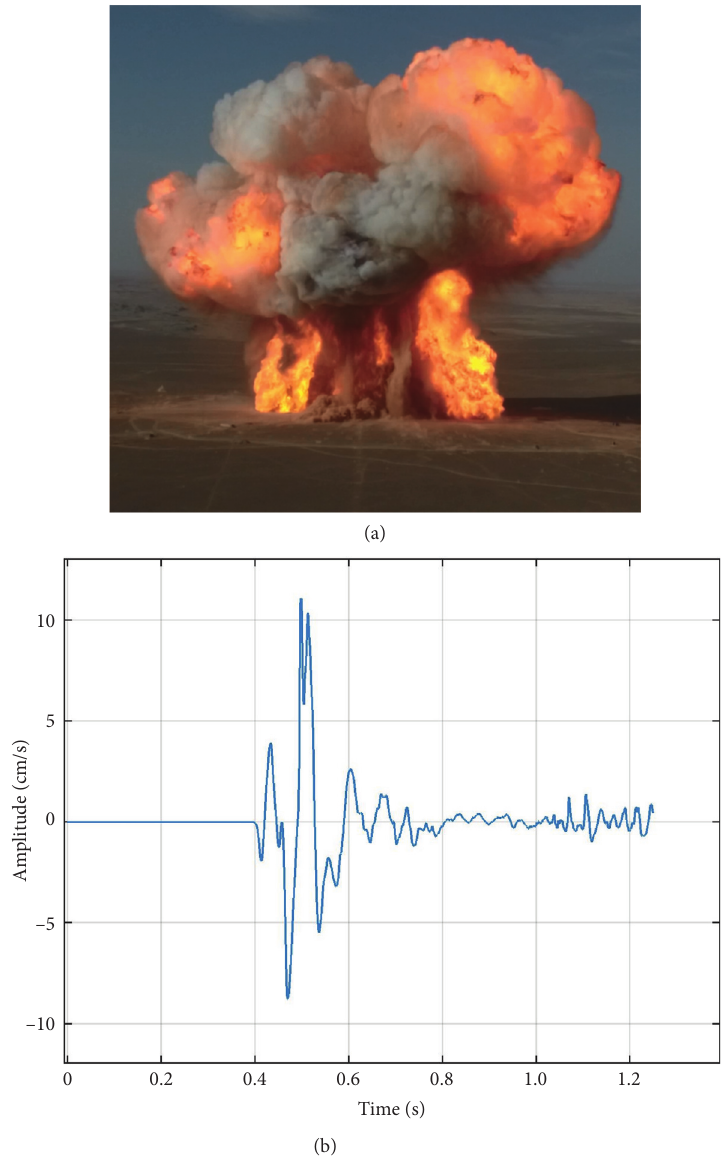
Figure 3: Pipeline explosion vibration. (a) OD1422-12Mpa explosion experiment of natural gas pipeline [26]. (b) Vibration